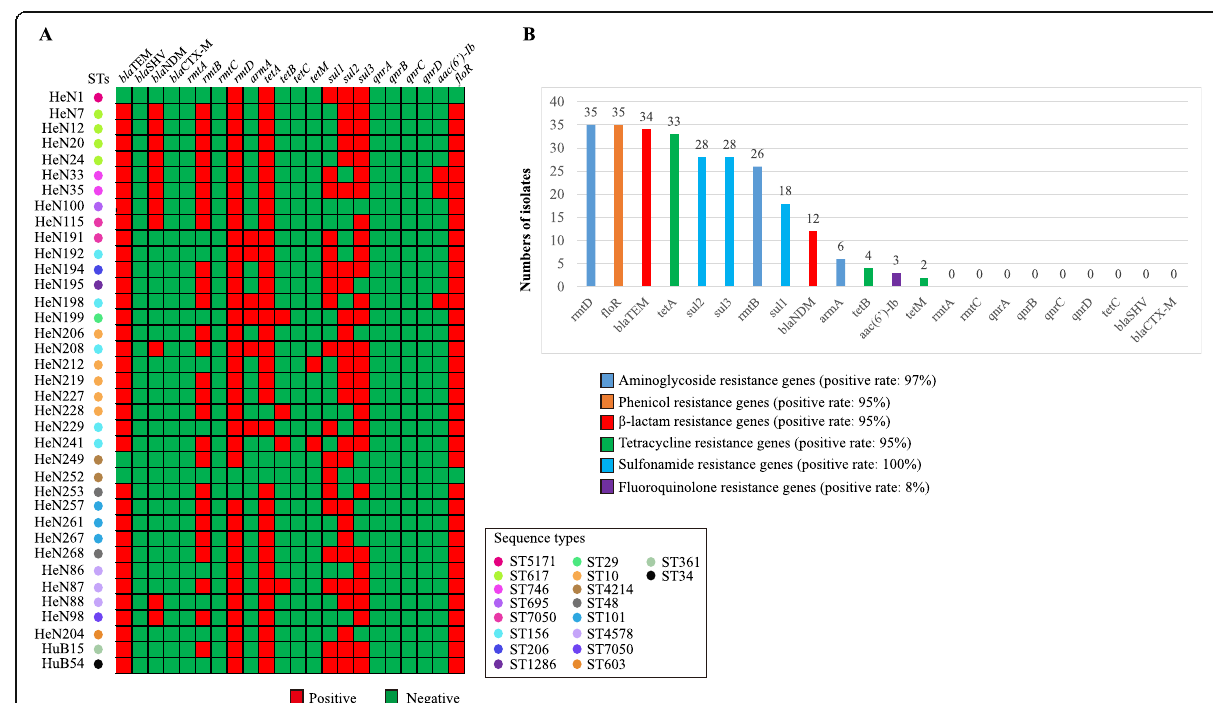
Fig. 3 Antimicrobial resistance genes carried by mcr -positive E. coli isolates. A Heat map showing detected antimicrobial resistance genes carried by the isolates. Small boxes marked in red and green represent positive and negative, respectively. B Column chart showing numbers of isolates positive for different detected antimicrobial resistance genes. Antimicrobial resistance genes accounting for resistance to the same antibiotic class are marked with columns in the same